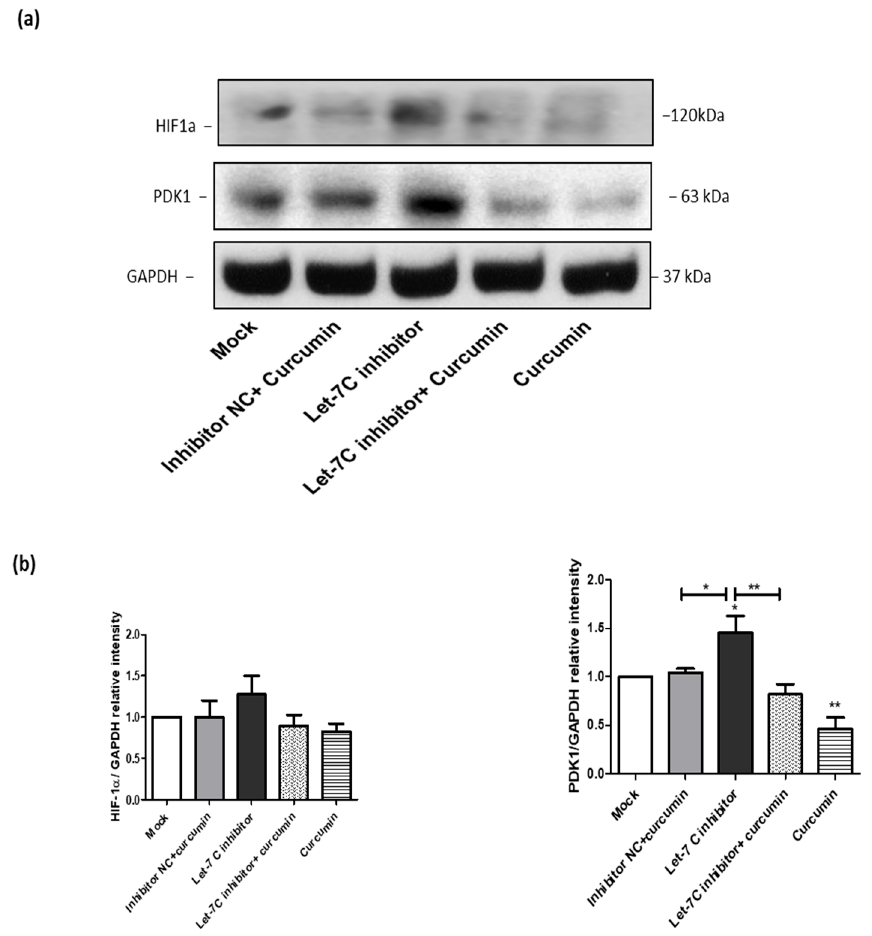
Figure 8. The effect of let-7C inhibition on glycolysis regulating proteins. ( a ) A representative western blot is shown from three independent let-7C transfection experiments, where expression of HIF-1 α and PDK1 was examined. ( b ) Band intensity of the indicated western blots were quantified densitometrically, normalized to GAPDH level and expressed as the mean relative intensity ± SEM ( n = 3). * p < 0.05 and ** p < 0.01. ONE-WAY ANOVA was used to analyse the